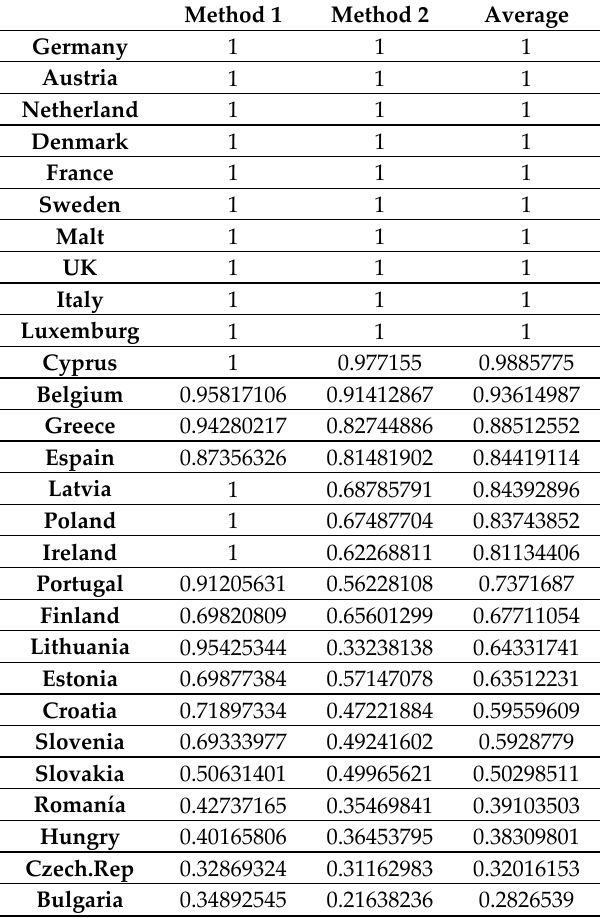
Table 12. Average values of Methods 1 and 2 for the average environmental efficiency of the 28 countries considered in the years 2005–2012. Source: self